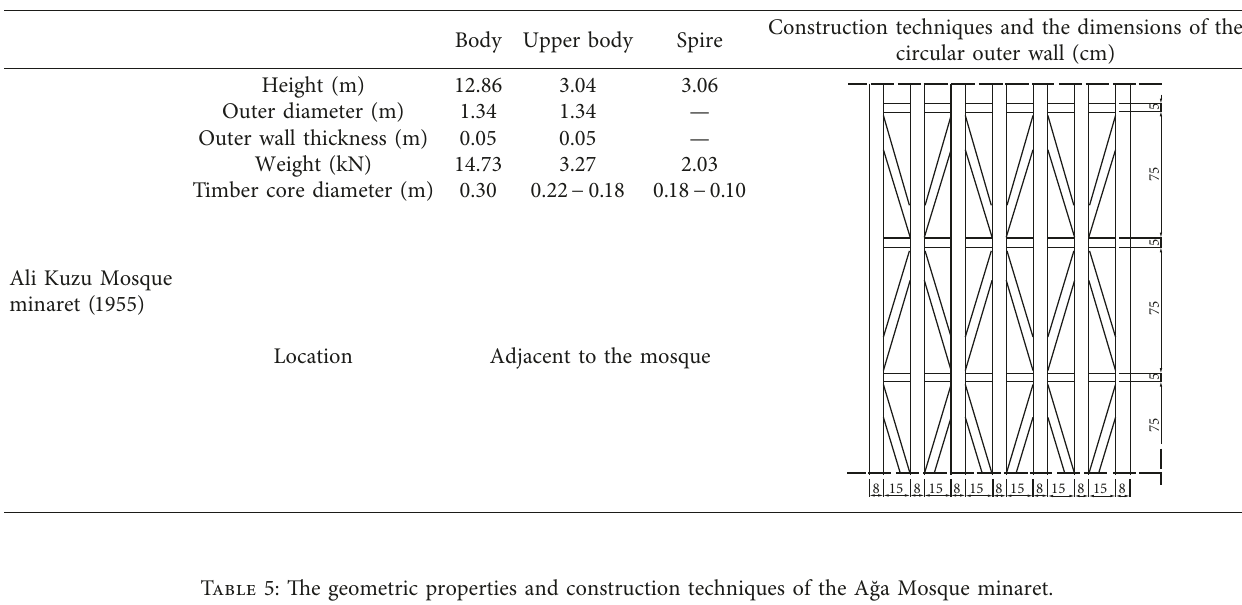
Table 5: The geometric properties and construction techniques of the A˘ga Mosque minaret. Construction techniques and the dimensions of the Body Upper body Spire circular outer wall